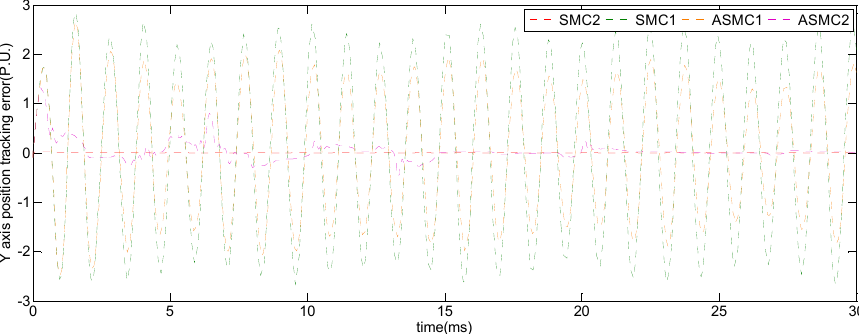
Figure 7. Y axis tracking error comparisons of SMC2, SMC1, ASMC2, and ASMC1.